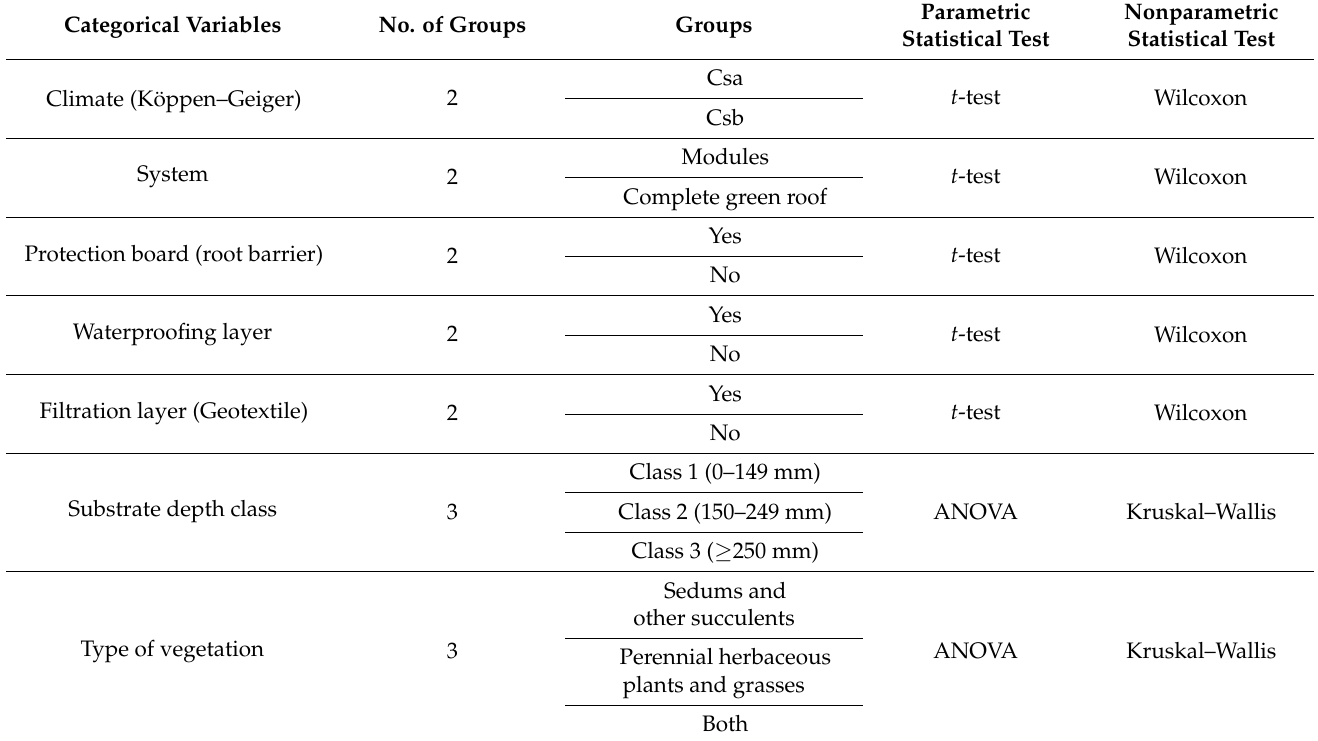
Table A1. Most appropriate test according to the number of groups and the statistical test assumptions. Categorical